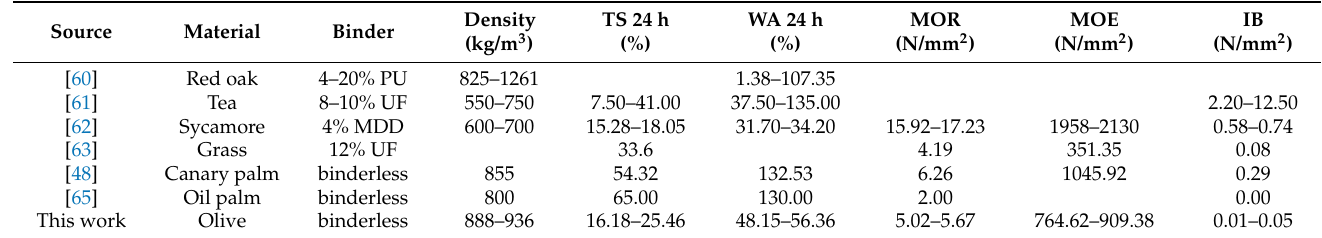
Table 5. Properties obtained with boards made of